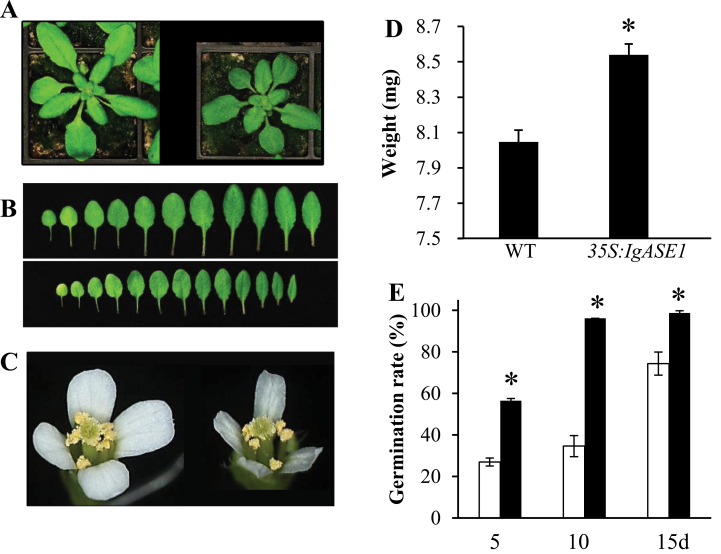
Phenotypic comparison of WT and 35S:IgASE1 transgenic Arabidopsis plants. (A) Three-week-old WT (left) and transgenic (right) plants. (B) Comparison of rosette leaves from WT (top) and transgenic (bottom) plants. (C) Flowers from WT (left) and transgenic (right) plants. (D) Dry weight of 500 seeds of WT and transgenic Arabidopsis. The experiment was repeated three times and the data were averaged; values are means ± SE; n = 500 for each experiment. (E) Percentage germination of seeds of WT (white columns) and transgenic (black columns) plants that were dried for 5, 10, and 15 days after harvest; 56 seeds were germinated on ½ MS. Values are means ± SE from three repeats. *P < 0.05 in a Student’s t test. This figure is available in colour at JXB online.